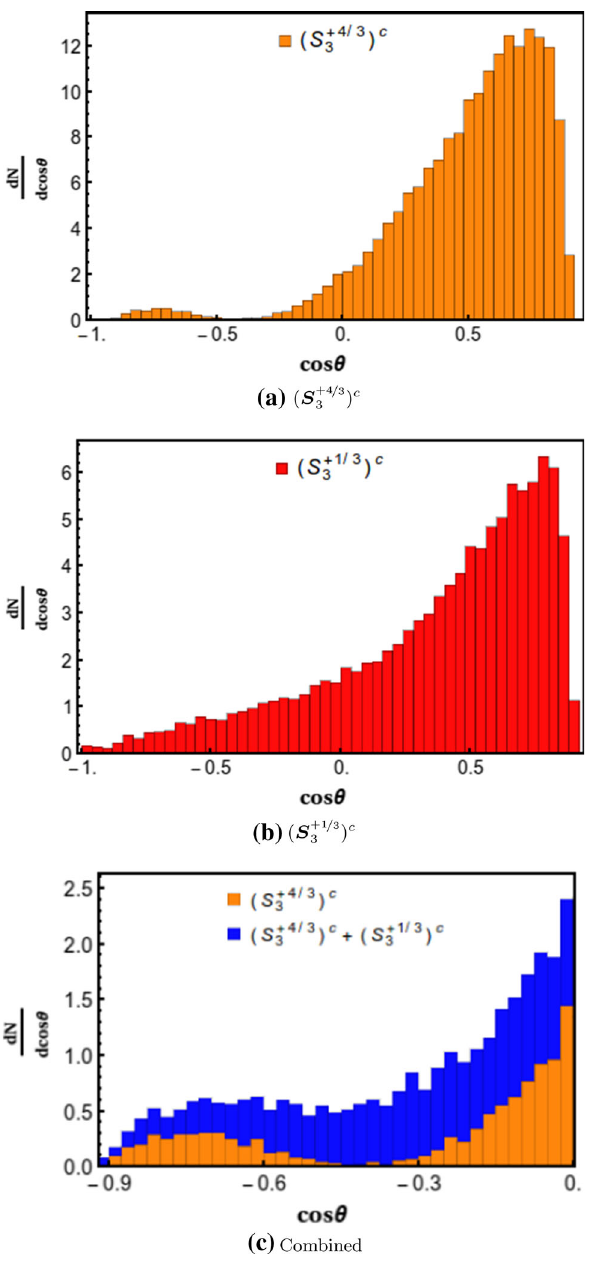
Fig. 9 Angular distribution for the associated production of recon- structed 70 GeV scalar triplet leptoquark S c (θ) with electron beam, at CM frame. The sub-figure a shows the angular distribution for ( S + 4 b shows the same for ( S + 1 in the CM frame of interaction